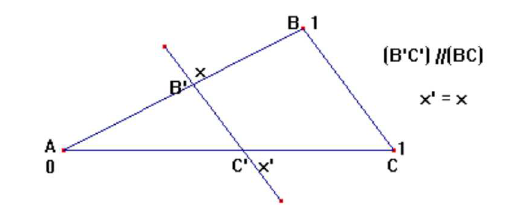
Fig. 2. Conservation des abscisses sur les